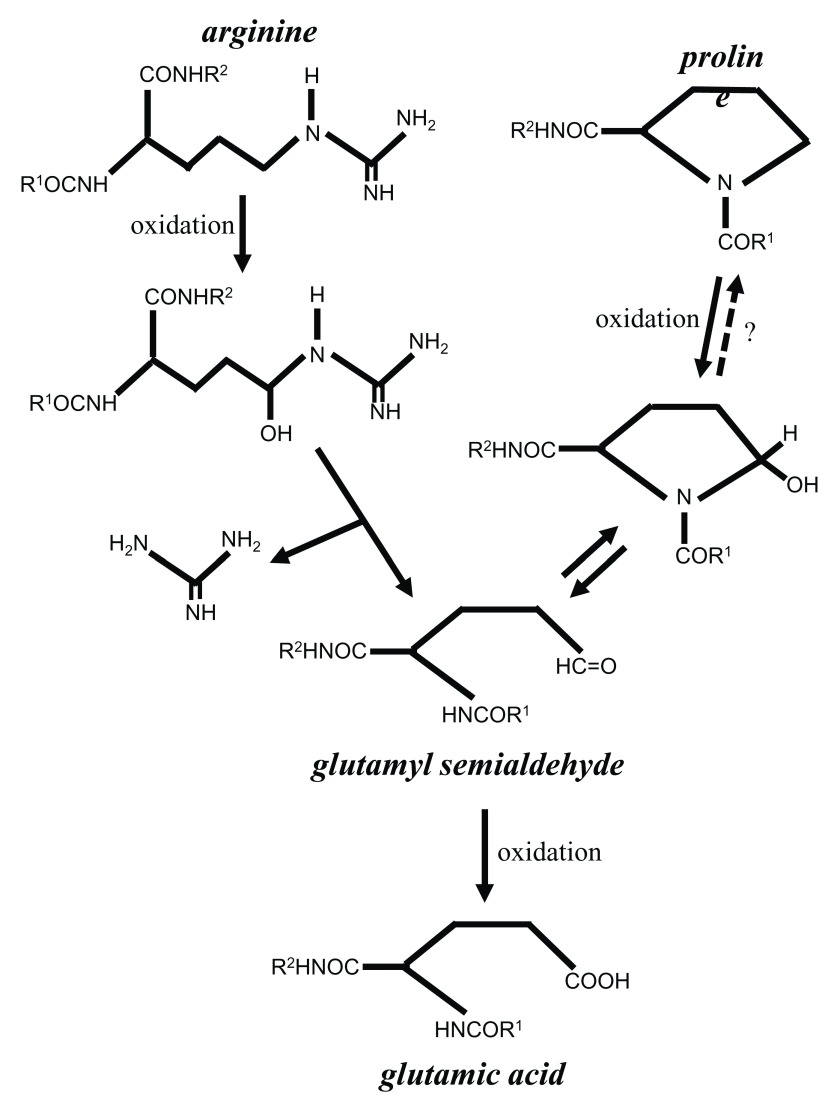
Iron-catalyzed oxidations of arginine and proline residues that result in the formation of glutamyl semialdehyde with a carbonyl group (
Amici
et al., 1989).